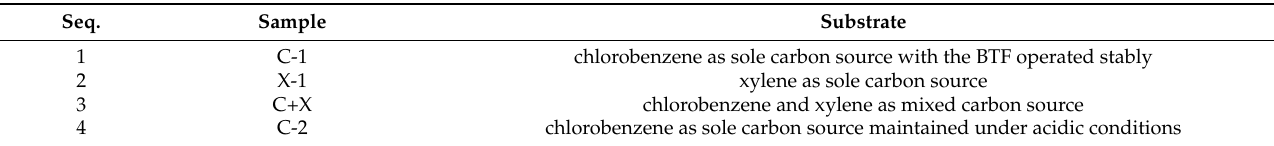
Table 1. Samples under different sampling conditions.